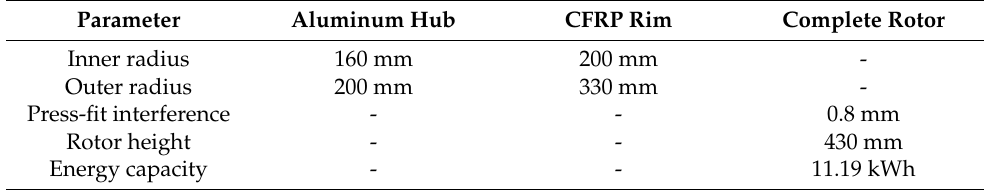
Table 3. Flywheel rotor rim dimensions, press-fit interference, and energy